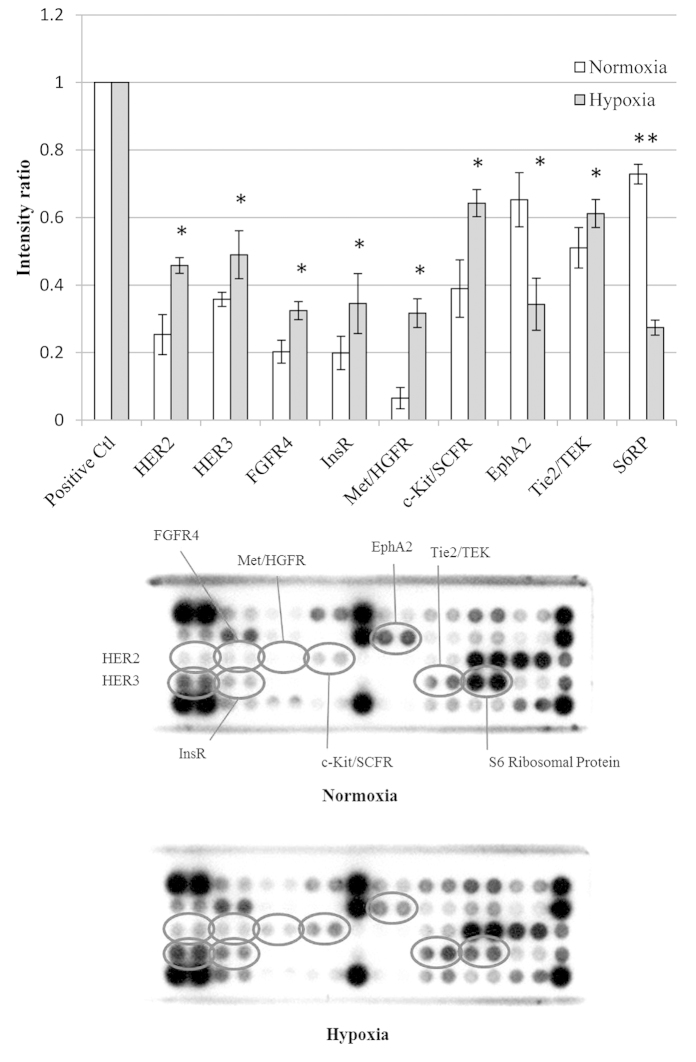
Effects of hypoxia on phosphorylation of signaling proteins. Lower panel shows a representative pair of chemiluminescent images produced using the PathScan RTK Signaling Antibody Array kit. The upper panel shows the pixel intensity ratio of phosphorylated signaling molecules. *P<0.05, **P<0.001 for the comparison between hypoxia and normoxia; values are presented as the mean ± standard deviation. Ctl, control; HER2, human epidermal growth factor receptor 2; FGFR2, fibroblast growth factor receptor 2; InsR, insulin receptor; Met/HGFR, hepatocyte growth factor receptor; SCFR, stem cell factor receptor; EphA2, ephrin type-A receptor 2; TEK, TEK tyrosine kinase, endothelial; S6RP, S6 ribosomal protein.